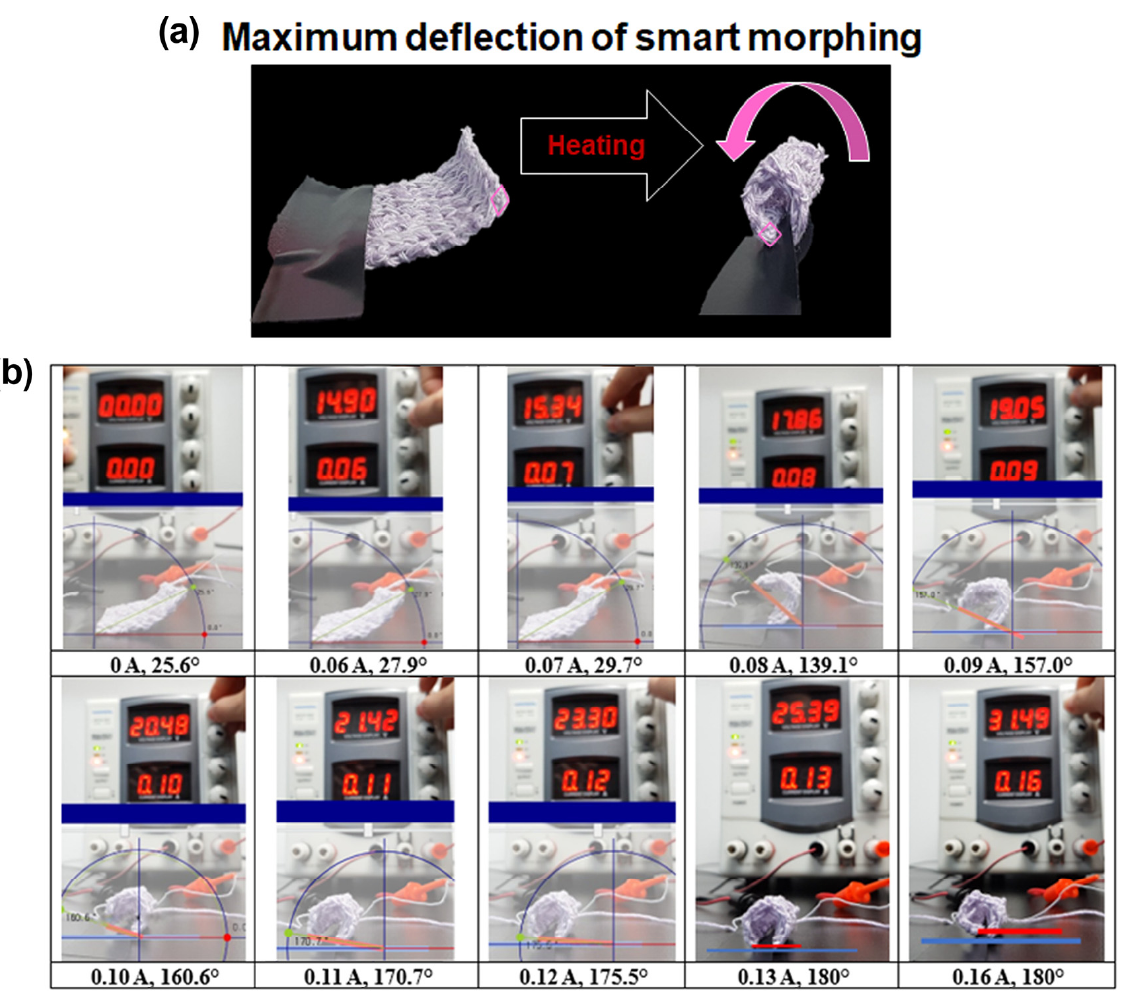
Figure 6. ( a ) The images of the actuator before and after actuation. ( b ) Experimental setup; measurement of the actuator’s deformation angle.